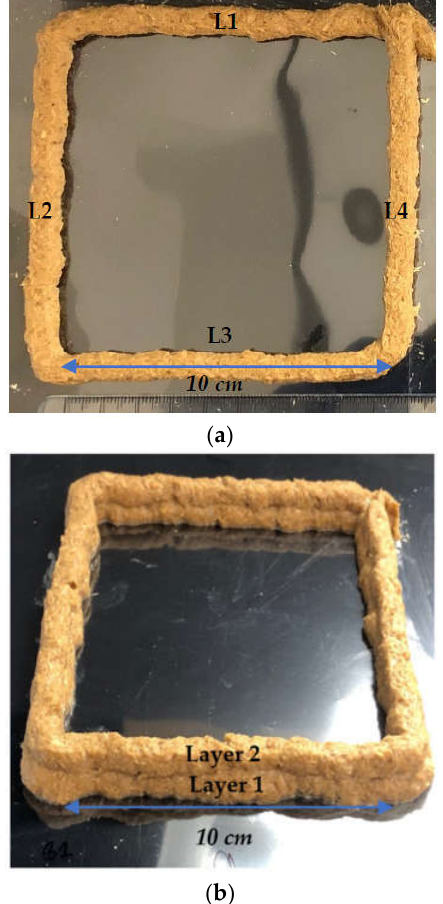
Figure 5. Printed samples used for assessing print quality: ( a ) extrudability sample; ( b ) shape stability sample.